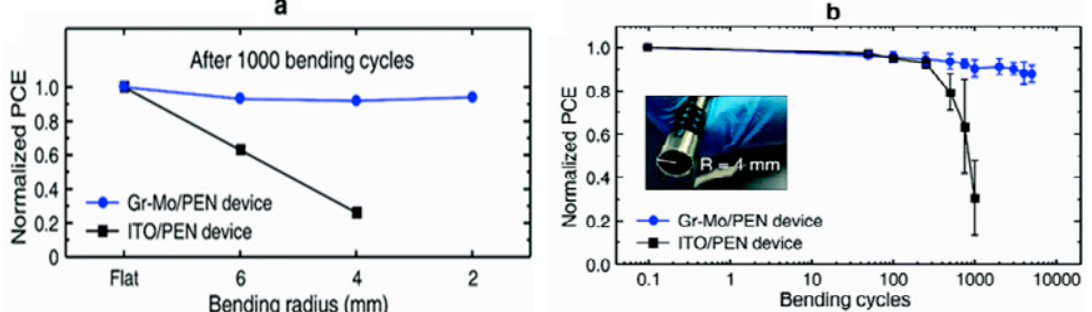
Figure 11. ( a ) Normalized PCEs of the Gr-Mo/PEN and ITO/PEN devices measured after 1000 bending cycles with bending radius of flat, 6, 4, and 2 mm. ( b ) Normalized PCEs vs bending cycles at a bending radius of 4 mm for the Gr-Mo/PEN and ITO/PEN devices. The inset photograph shows the actual bending situation [75].